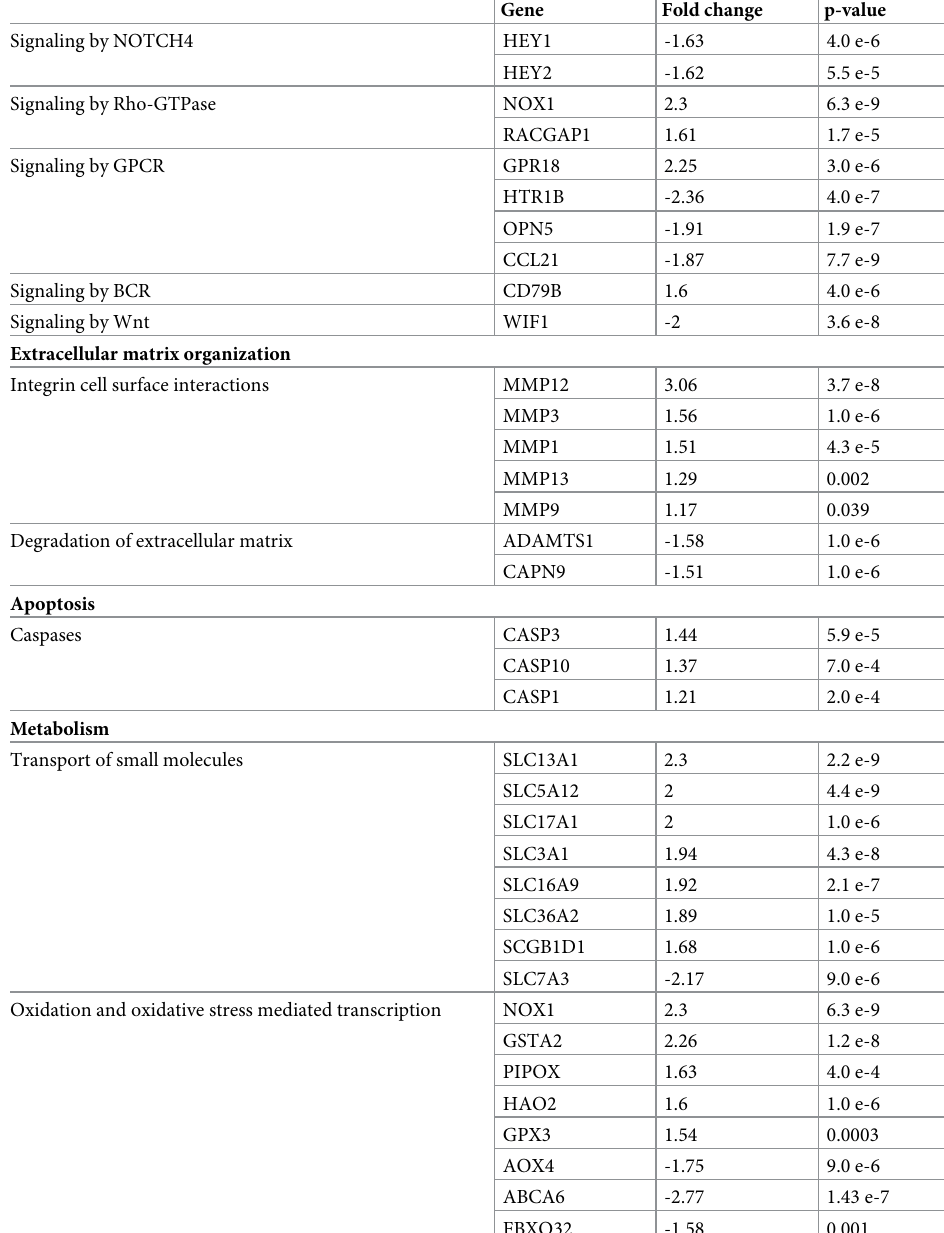
lipid metabolism (12 genes, 3.3%), f) translational control, ribosome processing, selenocysteine synthesis, SRP targeting, nonsense mediated decay (NMD), rRNA processing, mRNA editing (7 genes, 1.9%), and g) β defensins, antimicrobial peptides, metabolism of amino acids and derivatives (6 genes, 1.6%) as well as other smaller gene clusters found to be upregulated. Of the genes downregulated in DED (FC < -1.3, p < 0.05), 16% were found in functional modules. These genes include genes involved in: a) transcriptional control, nuclear